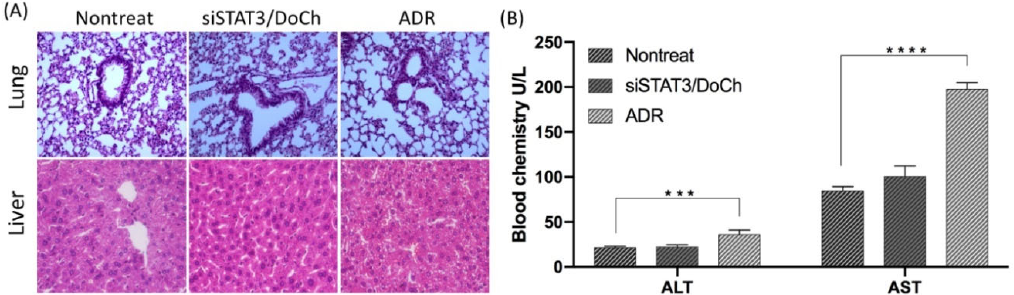
Figure 8. Assessment of DoCh LNP toxicity. ( A ) H&E staining of lung and liver from nontreated, siSTAT3/DoCh treated and ADR treated mice. Magnification: ×400. ( B ) Measurement of serum ALT and AST from nontreated, siSTAT3/DoCh treated and ADR treated mice. *** p value is < 0.001; **** p value is < 0.0001.